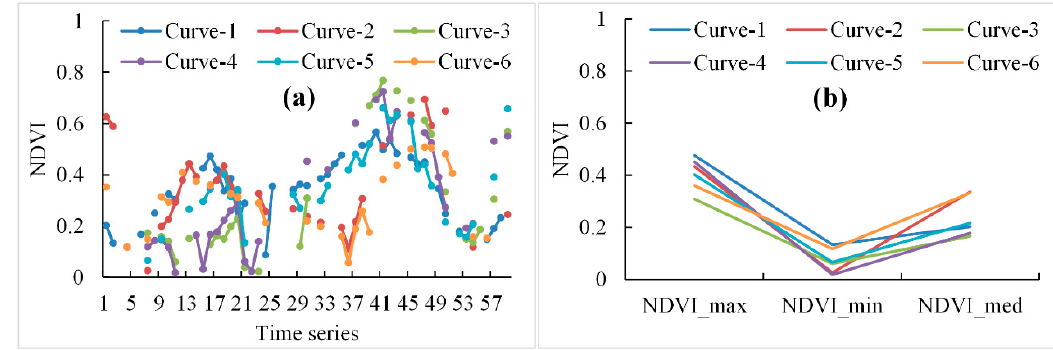
Figure 11. ( a ) The original time-series NDVI curves and ( b ) the composited NDVI curves of winter crops, derived from Sentinel-2 and Landsat-7 and -8 images from 20 September 2017 to 15 July 2018.